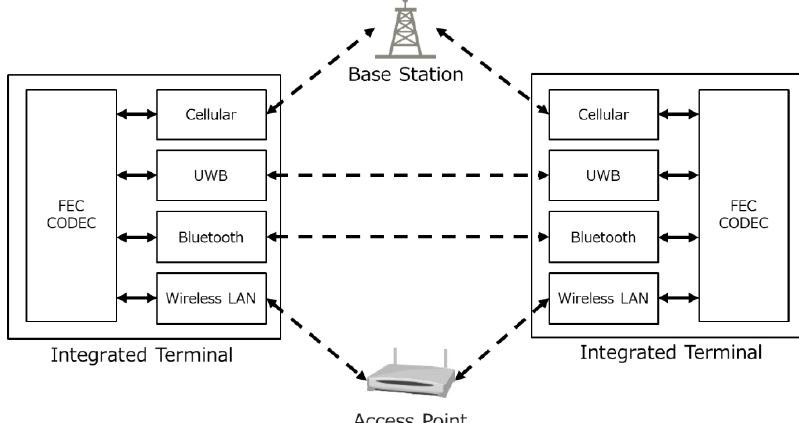
Figure 1. Proposed dependable wireless system. Integrated terminal uses multiple radio access technologies (RATs) such as cellular, ultra-wide band (UWB), Bluetooth, and wireless local area network (LAN) to communicate simultaneously.